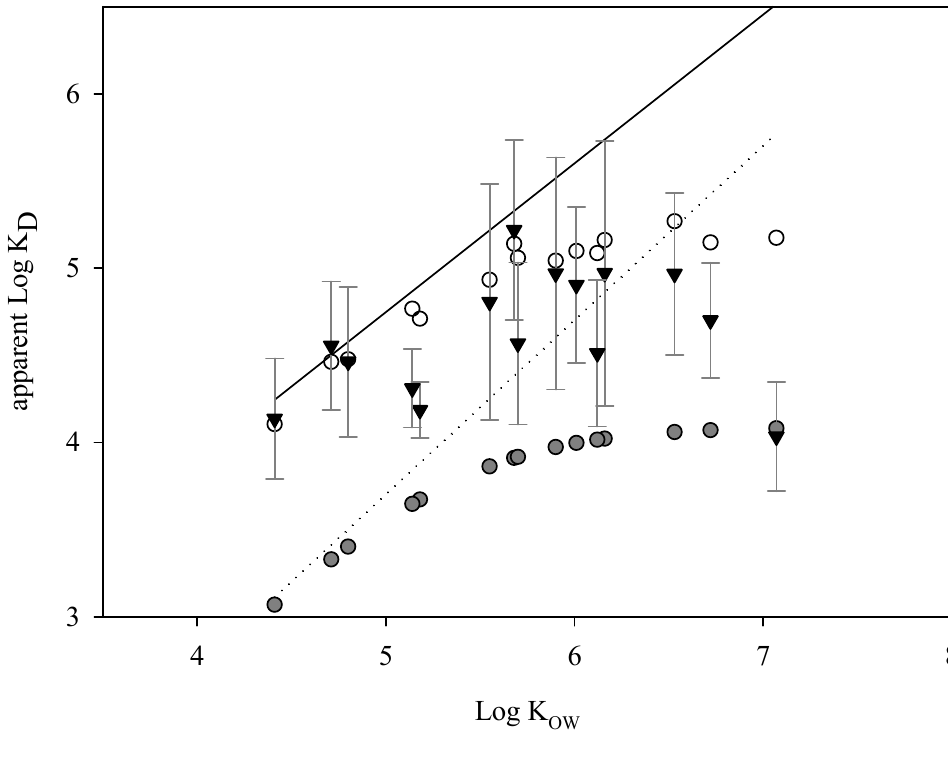
) between SS and water with respect to Figure 9. Apparent distribution coefficients (K D : observed K versus estimated K from Equation 1 and 2 in the text. Error bars, K OW D D gray-filled ( ● ) and open circles, and triangles ( ▼ ) denote one standard deviation, average s estimated by Equation 1 and 2, and observed values in this study, respectively. Dotted K D s estimated by Equation 1 and 2 with DOC value set to and solid lines represent K D zero,